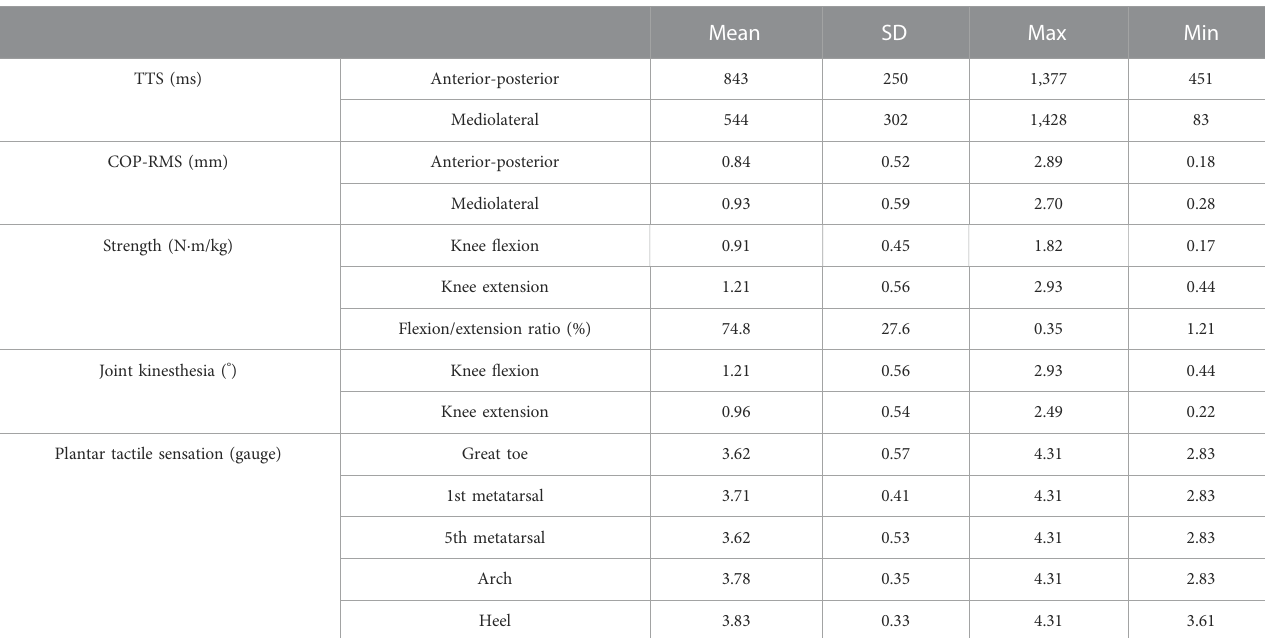
TABLE 1 Descriptive characteristics of outcome